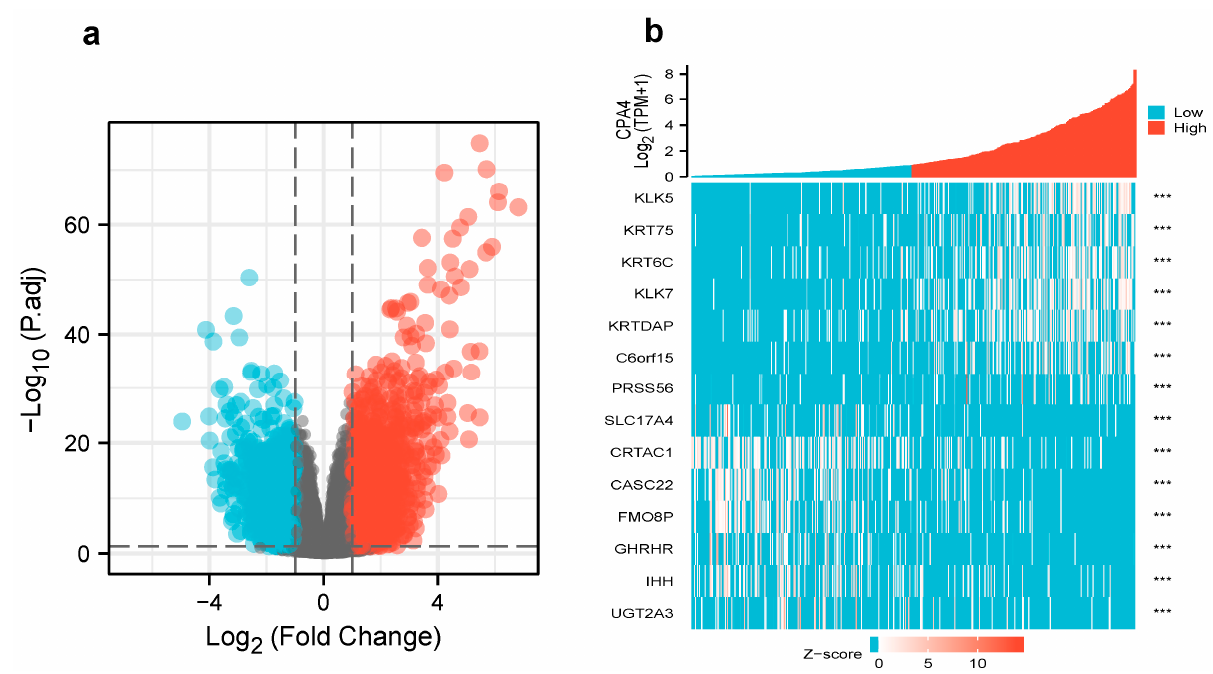
Figure 3. ( a ) Volcano plot of differentially expressed genes (DEGs) connected with the expression of CPA4; ( b ) heatmap of differentially expressed genes (DEGs) connected with the expression of CPA4. * p < 0.05; ** p < 0.01; *** p < 0.001.